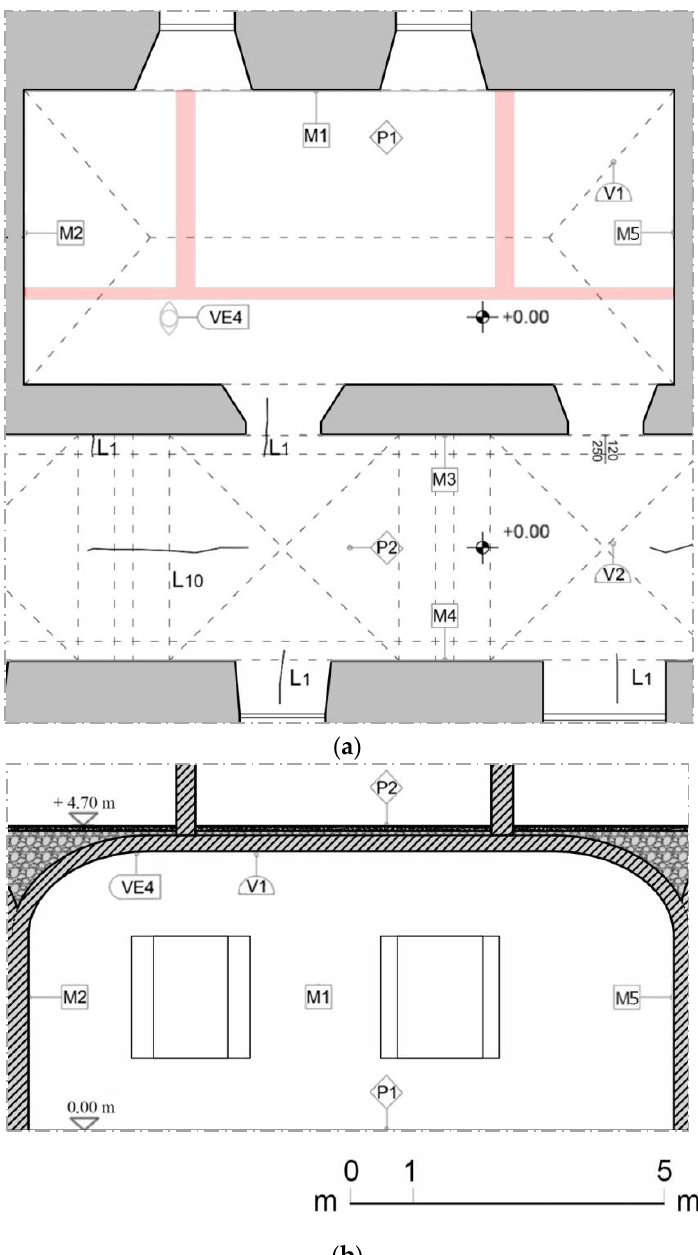
Figure 9. Survey of the ground floor span of Vanvitelli’s Modulus: ( a ) The plan: in light red, the bulk of the overhead in falso walls; ( b ) an extract from a generic cross section, where: lesions on the structural elements (L), masonry walls (M), pavings (P), masonry vaults (V), videoendoscopies (VE).